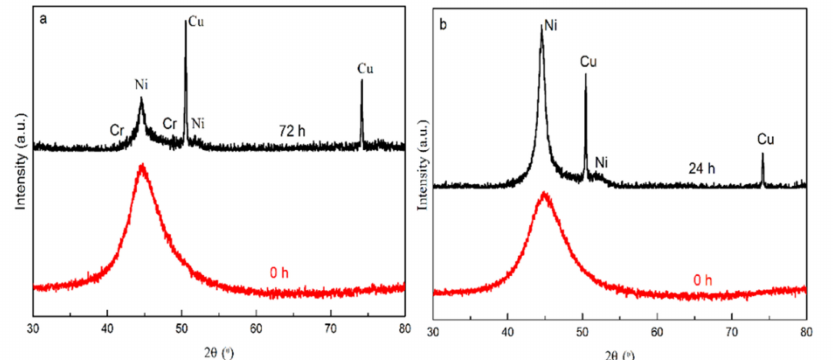
Figure 15. XRD patterns of the ( a ) NiCrP and ( b ) NiP alloy coatings before and after immersion in the 1 mol · L − 1 HCl